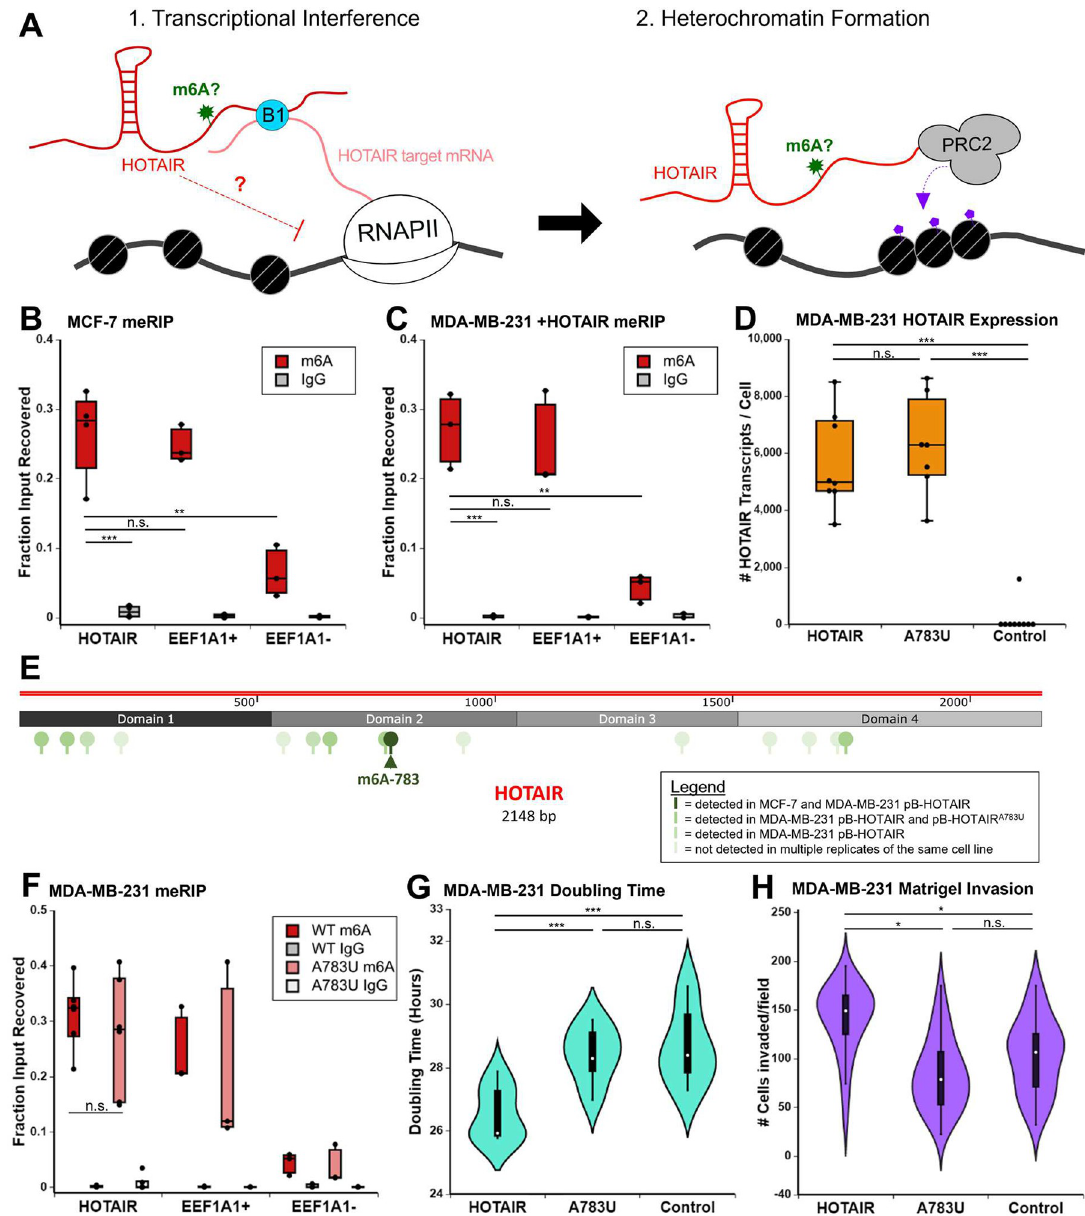
Fig 1. LncRNA HOTAIR is m6A modified. AU : AbbreviationlistshavebeencompiledforthoseusedinFigs 1 to 6 : Pleaseverifythatallentriesarecorrect : (A) General model for HOTAIR mechanism. HOTAIR is initially recruited to its target loci via RNA–RNA interactions with its mRNA targets that is mediated by hnRNP B1. HOTAIR association with chromatin induces transcriptional interference via an unknown mechanism, promoting heterochromatin formation by PRC2 through H3K27me3. This paper investigates the role of m6A on HOTAIR. (B, C) m6A RNA immunoprecipitation performed with an m6A antibody or IgG control in MCF-7 breast cancer cells (B) or MDA-MB-231 breast cancer cells with transgenic overexpression of HOTAIR (C). An m6A- modified region in EEF1A1 (EEF1A1 m6A) is a positive control, while a distal region in EEF1A1 that is not m6A modified (EEF1A1 distal) serves as a negative control. Three biological replicates are included. (D) Number of HOTAIR transcripts in MDA-MB-231 cells overexpressing WT HOTAIR, A783U HOTAIR, or an Anti-Luciferase control RNA. Experiments include 3 biological replicates each on 3 independently generated clones. (E) m6A sites detected in HOTAIR-expressing cells in 6 experiments (light green to dark green, scale of increasing occurrences). m6A site 783 (dark green, arrow) was detected in every experiment except where it was mutated. (F) m6A RNA immunoprecipitation performed with an m6A antibody or IgG control on MDA-MB-231 cells overexpressing WT HOTAIR, HOTAIR A783U, or an Anti-Luciferase control; 3–5 biological replicates were performed. (G) Doubling time of MDA-MB-231 overexpression cell lines described in (D). Experiments include 3 biological replicates each on 3 independently generated clones. (H) Quantification of Matrigel invasion assays performed with MDA-MB-231 overexpression cell lines described in (D). Four biological replicates were performed. Numerical values in panels 1B–D, 1F–H are included in S2 Data. lncRNA, long noncoding RNA; m6A, N6-methyladenosine. https://doi.org/10.1371/journal.pbio.3001885.g001 PLOS Biology | https://doi.org/10.1371/journal.pbio.3001885 November 28,